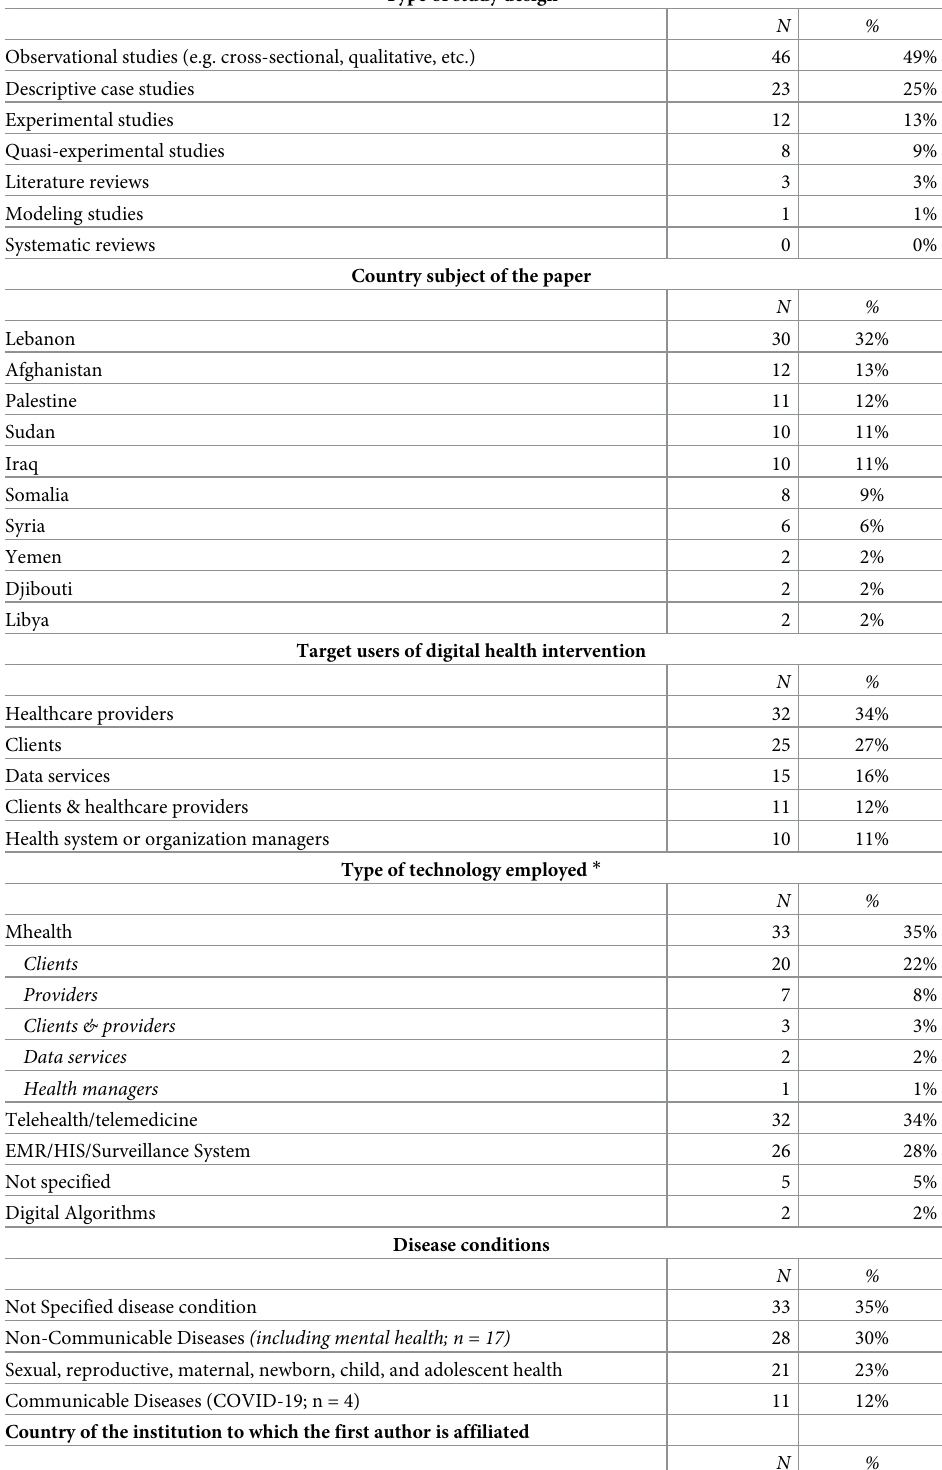
Table 1. Characteristics of included studies (N = 93).